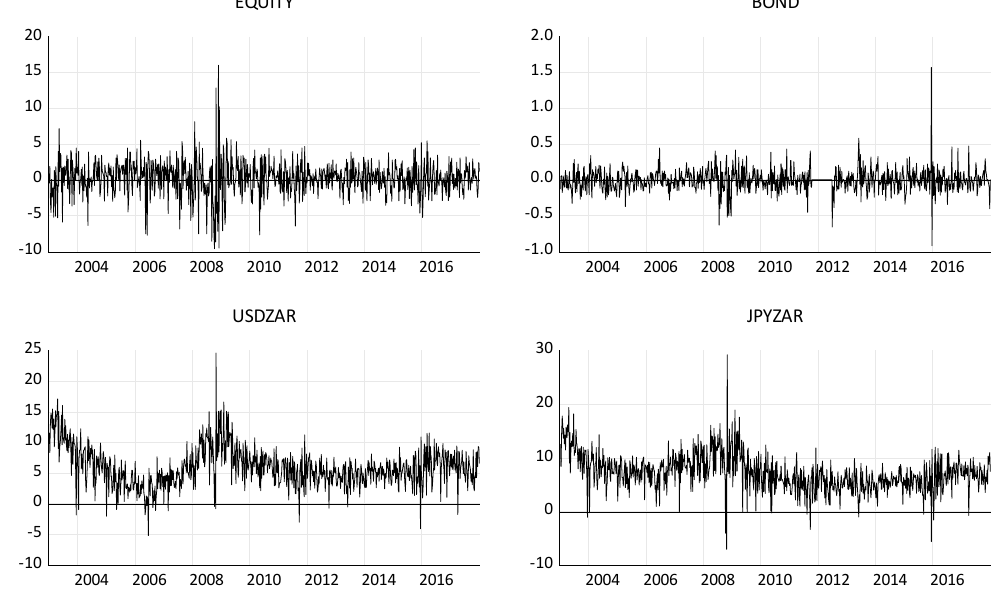
Figure 1. Trends of the main series. Note: EQUITY represents r JSE , BOND denotes r Bond , USDZAR denotes r CT/dollar , and JPYZAR represents r CT/yen .